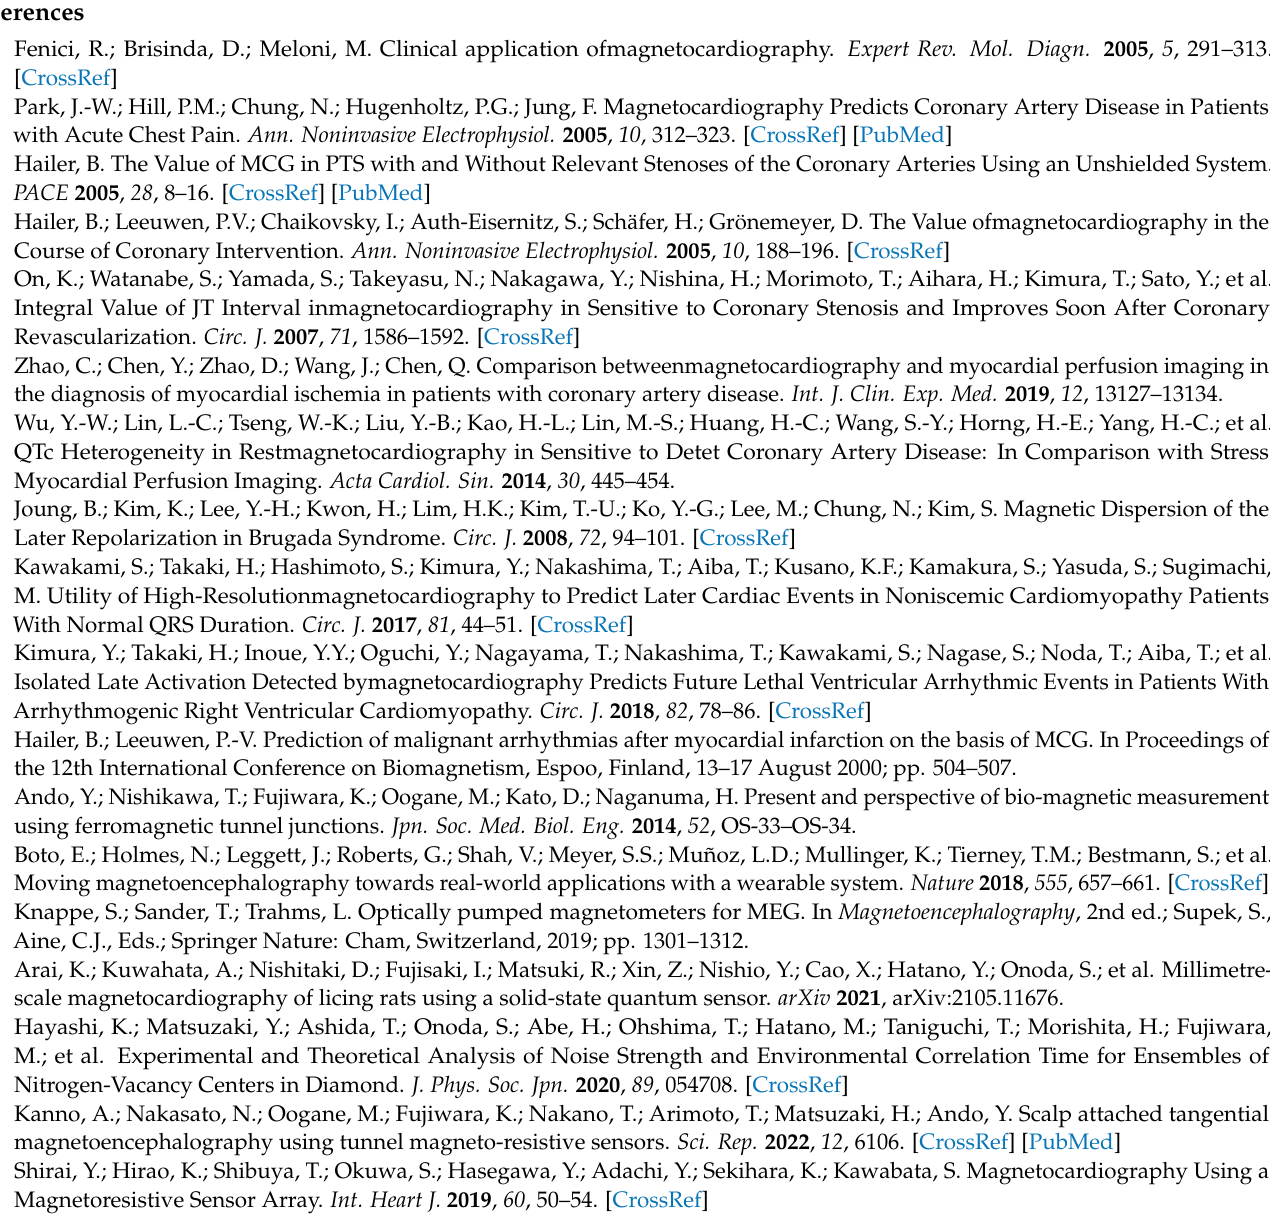
Figure A2. Magnetic domain structure observed in patterned deposited wafer of ( a ) Sub. Si, SiO 2 /Ta 5/Ru 20/Ta 5/Co 70.5 Fe 4.5 Si 15 B 10 170/Ru 0.4/Co 40 Fe 40 B 20 3/Ta 2.5 and ( b ) Sub. Si, SiO 2 /Ta 5/Ru 20/Ta 5/Co 70.5 Fe 4.5 Si 15 B 10 100/Ru 10/Co 70.5 Fe 4.5 Si 15 B 10 100/Ru 0.4/Co 40 Fe 40 B 20 3/Ta 2.5. The pattern sizes are 100 × 140 µ m in both. The broken lines on the right-hand diagram show the observed